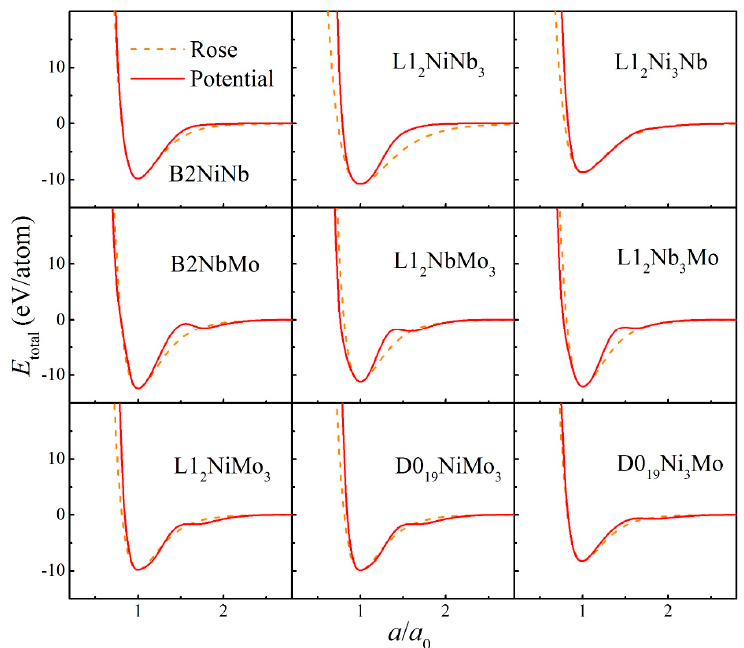
Figure 1. Total energies calculated from interatomic potential ( Red solid line ) and corresponding Rose equation [65] ( Orange dashed line ) as a function of lattice constant for various compounds in the Ni-Nb-Mo system.